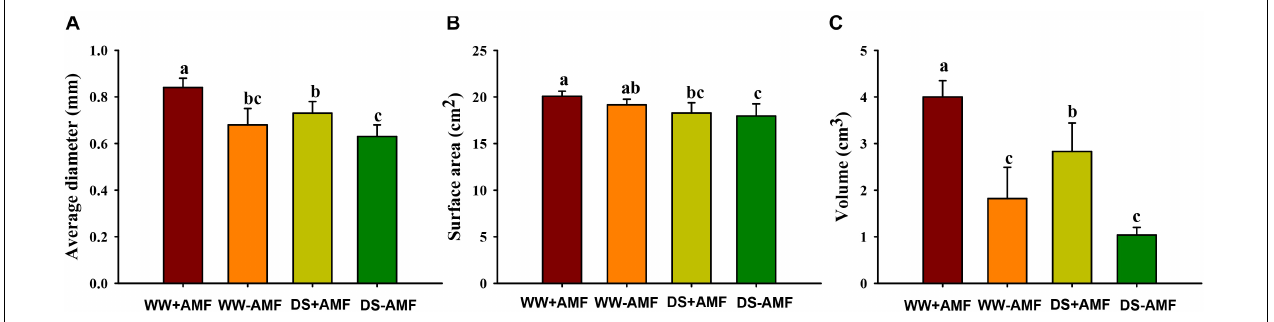
FIGURE 1 | Effects of Funneliformis mosseae on root average diameter (A) , root surface area (B) , and root volume (C) of trifoliate orange ( Poncirus trifoliata ) seedlings subjected to well-watered (WW) and drought stress (DS). Data (means ± SD, n = 4) followed by different letters above the bars indicate significant differences ( P < 0.05) between treatments. TABLE 1 | Effects of Funneliformis mosseae on leaf gas exchange of trifoliate orange ( Poncirus trifoliata ) seedlings subjected to well-watered (WW) and drought stress (DS).